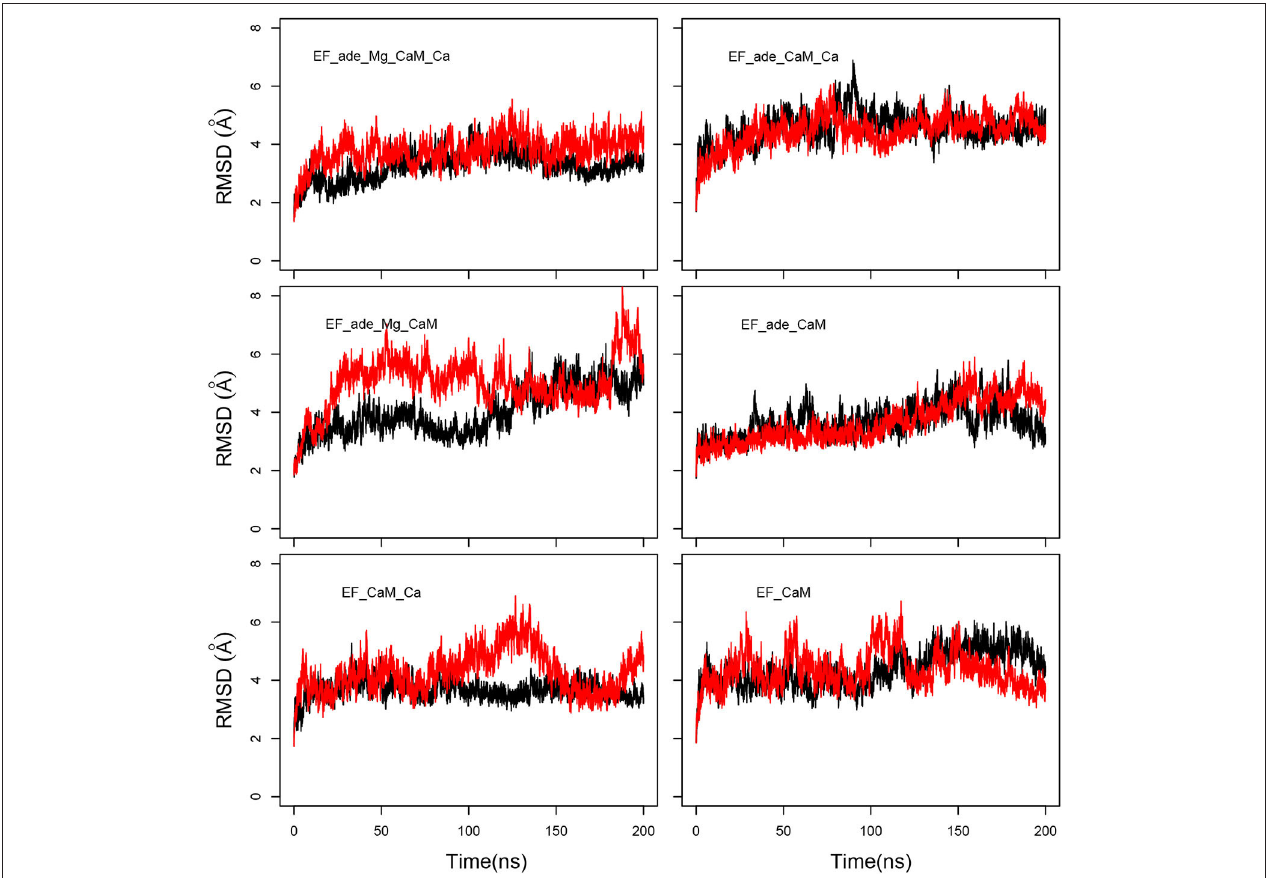
FIGURE 2 | Coordinate root-mean-square deviations (RMSD: Å) of the backbone heavy atoms of EF and CaM with respect to the PDB structure 1PK0, calculated along all trajectories. For each trajectory, the black and red curves correspond to the two replicas R1 and R2.